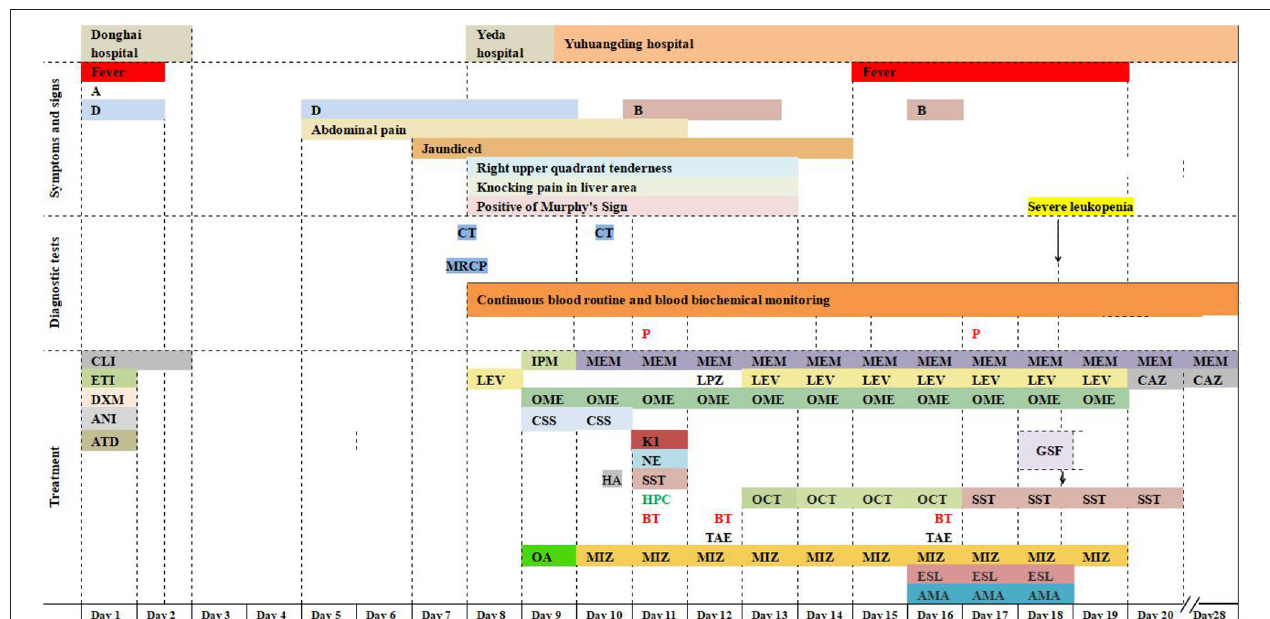
FIGURE 2 | Timeline. Symptoms, diagnostic tests, and treatment. A, anorexia; B, intermittent bloody stools; D, intermittent diarrhea; CT, computed tomography; MRCP, magnetic resonance cholangiopancreatography; P, S . Typhi was isolated by blood culture; CLI, clindamycin 600mg on day 1, 300mg on day 2; ETI, etimicin 100mg; DXM, dexamethasone 5mg; ANI, anisodamine 10mg; ATD, antondine 2ml; LEV, levofloxacin 0.5 g/day; IPM, imipenem; MEM, meropenem 1 g/8h; LPZ, lansoprazole 60mg; OME, omeprazole 40mg iv bid initially and then 40mg iv qd; CSS, cefoperazone and sulbactam sodium 2 g/8h; HA, hemocoagulase agkistrodon 2 IU iv; K1, vitamin K1 20mg ivgtt; NE, norepinephrine 400 µ g/h; OCT, octreotide 8 µ g/h; SST, somatostatin 250 µ g/h; HPC, human prothrombin complex 600 IU ivgtt; BT, blood transfusions 3.5 units on day 11, 12 units on day 12, and 4 units on day 16; OA, ornithine aspartate for injection 5g; MIZ,